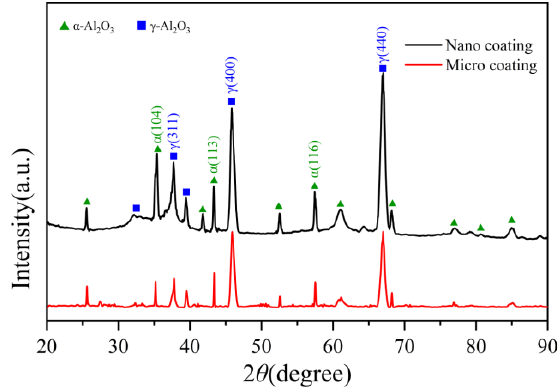
Figure 4. XRD pattern of Al 2 O 3 coating.